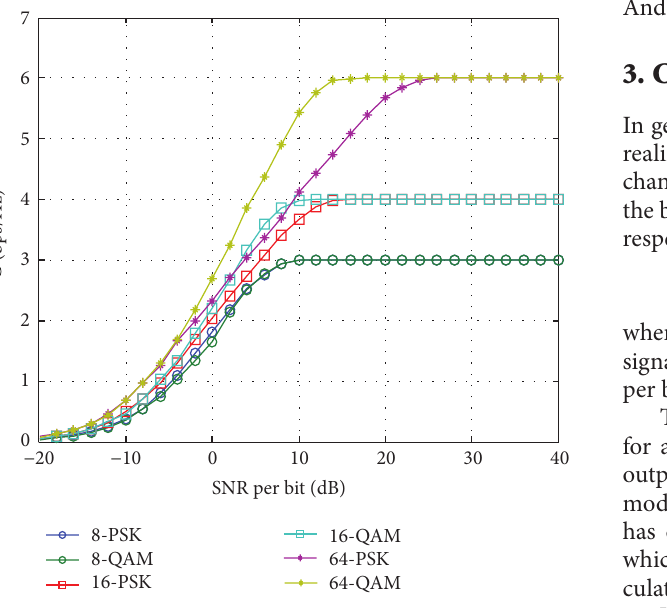
Figure 4: Relations between capacities of 𝑀 -ary PSK and QAM with the same average power.